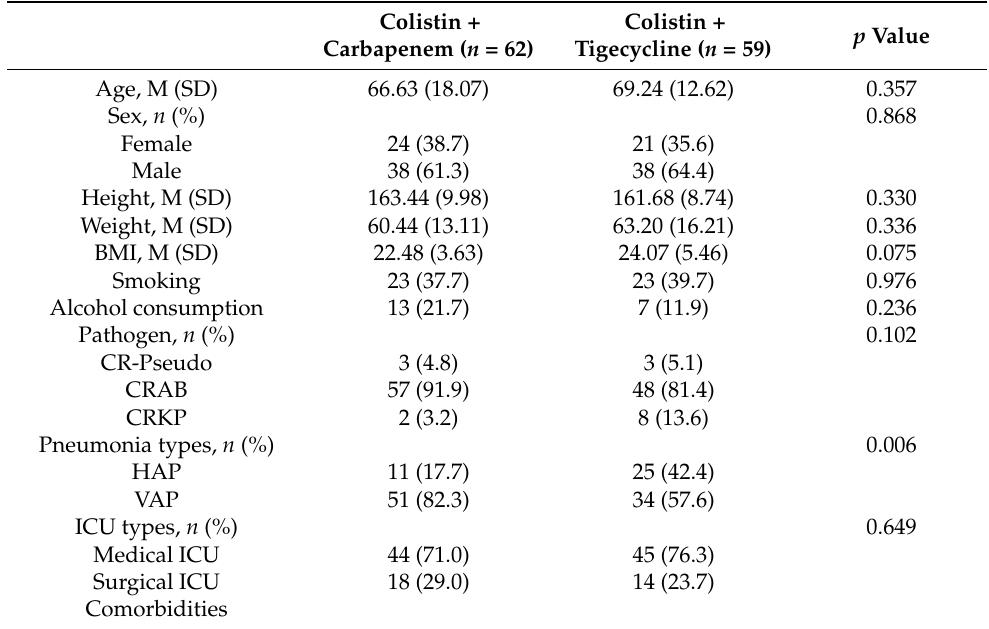
Table 1. Demographic characteristics and disease severity of ICU patients treated with colistin + carbapenem or colistin +